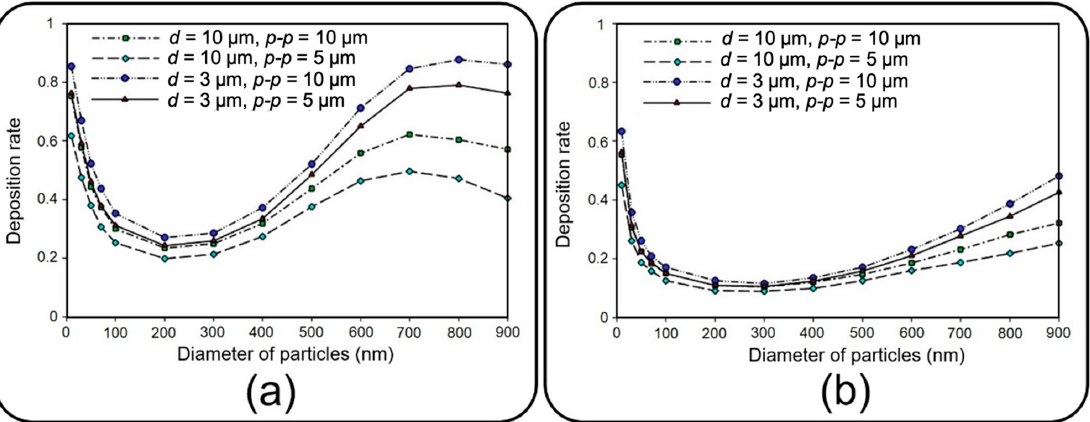
Figure 8. Deposition rate of airborne NPs of diameter ranging from 10 nm to 900 nm on the substrate of the air channel with different membrane porosities and airflow velocities of ( a ) 0.3 mm/s and ( b ) 1 mm/s.